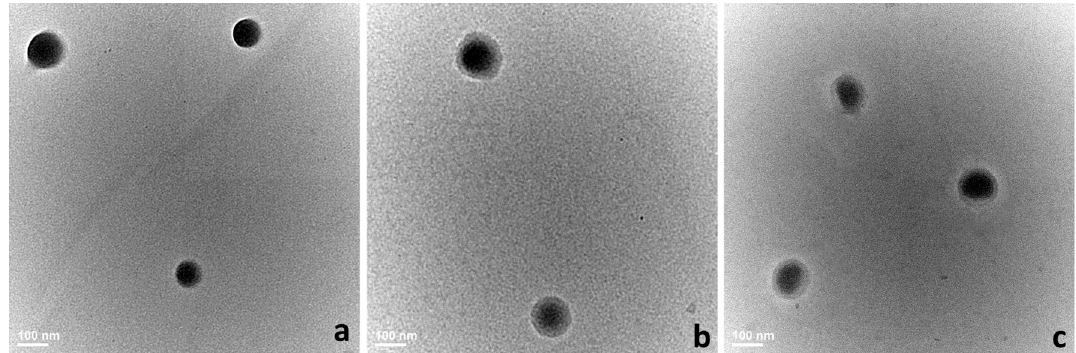
Figure 2. The morphology of analyzed systems evaluated through TEM microscopy. ( a ) PLGA-IMC; ( b ) HPON-IMC; and ( c ) HPOE-IMC.